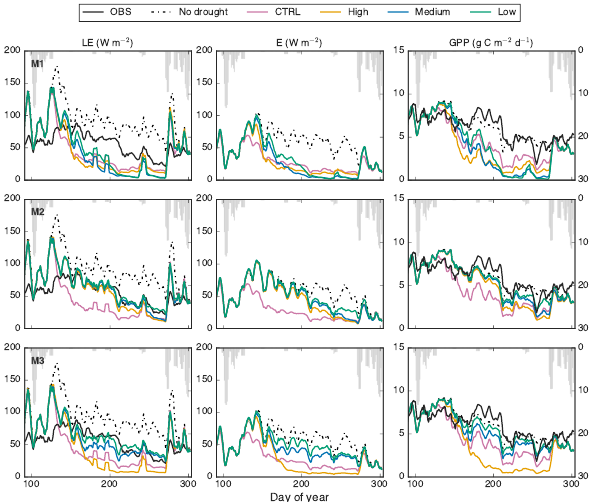
Figure 6. A comparison of the observed (OBS) and modelled latent Heat (LE), transpiration ( E ) and gross primary productivity (GPP) at the Castelporziano site during 2003. Simulations show the con- trol (CTRL) and the three parameterisations that represent a spec- trum of behaviour ranging from a high to low drought sensitivity, and the tested methods to obtain a weighted estimate of soil water potential ( (cid:57) S ) across CABLE’s soil layers (M1–M3). M1 uses a root-biomass weighted soil water content converted to (cid:57) S , M2 cal- culates (cid:57) S by integrated soil water content over the top 1.7m of the soil, and M3 is calculated using a dynamic weight across soil layers. The data have been smoothed with a 5-day moving window to aid visualisation and the grey bars show daily rainfall.